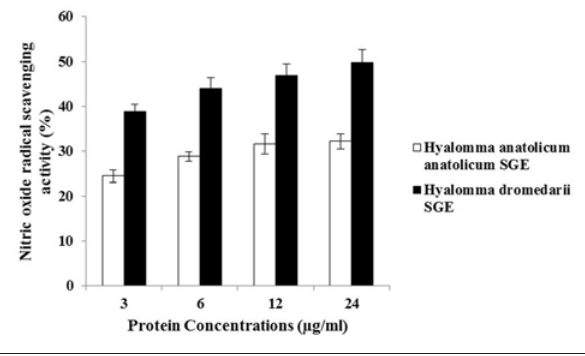
Figure-1: Nitric oxide radical scavenging activity (%) in salivary gland extracts of Hyalomma anatolicum anatolicum and Hyalomma dromedarii ticks. Data presented as mean±standard error; N=6 groups, each group containing six ticks.